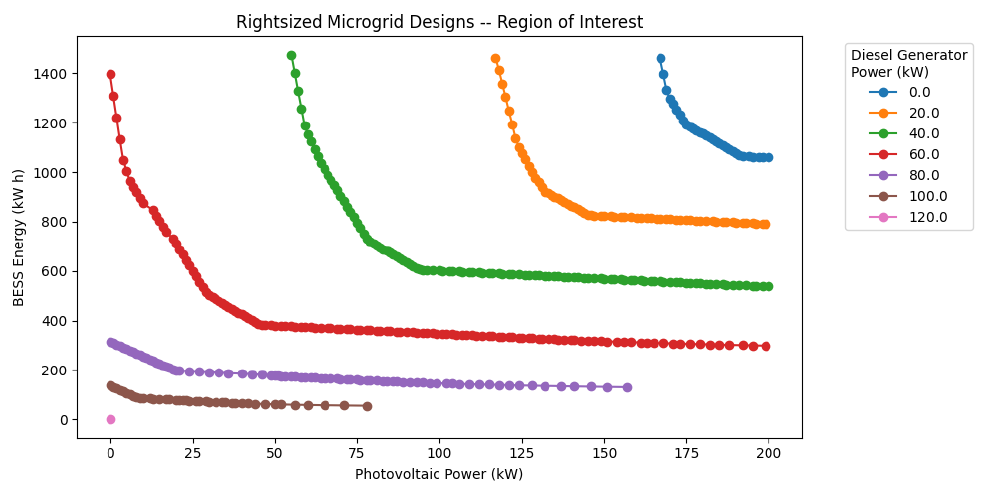
Figure 10. Microgrid designs rightsized to meet power load requirements.